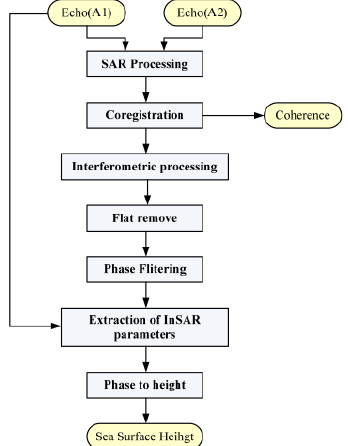
Figure 4. Flowchart of data processing for determining sea surface heights using the AIRAS.